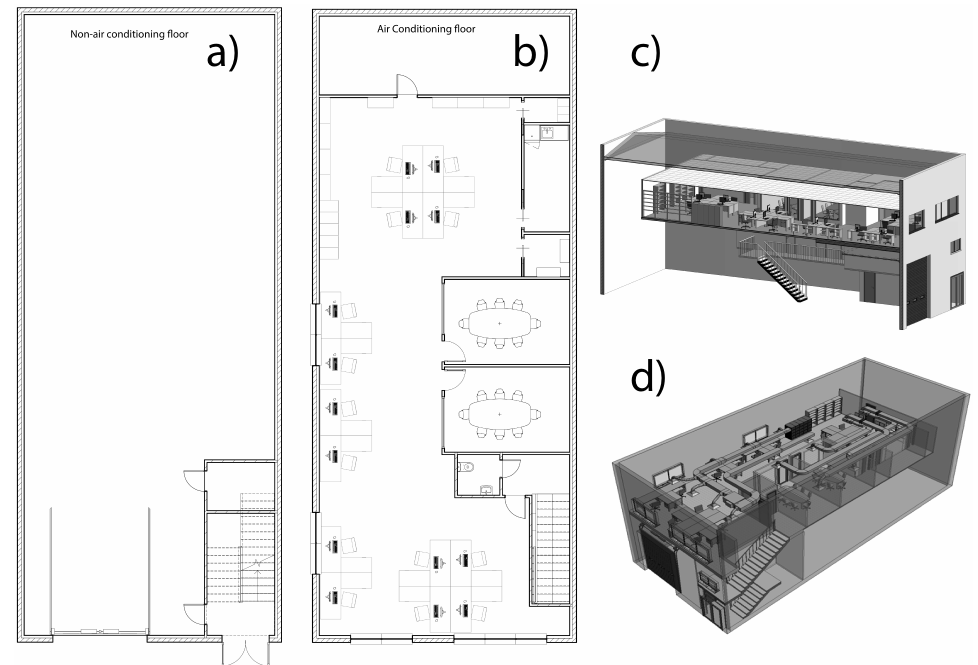
Figure 1. Architectural blueprints of the first case study building (Spain): ( a ) ground floor; ( b ) first floor. Numerical model geometry: ( c ) Northeast view and ( d ) Southwest